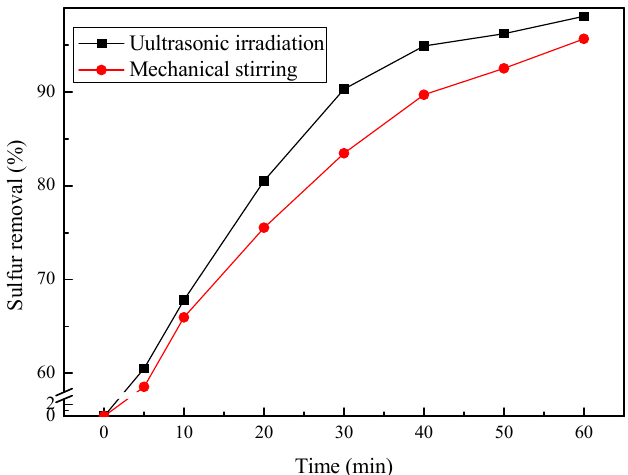
Figure 9. The effect of ultrasound on DBT removal. Experimental conditions: temperature, 0 °C; initial sulfur concentration, 500 ppm; catalyst dosage, 2.5 wt.% of n -octane; ozone dosage, 0.1 g/h; reaction time, 60 min.